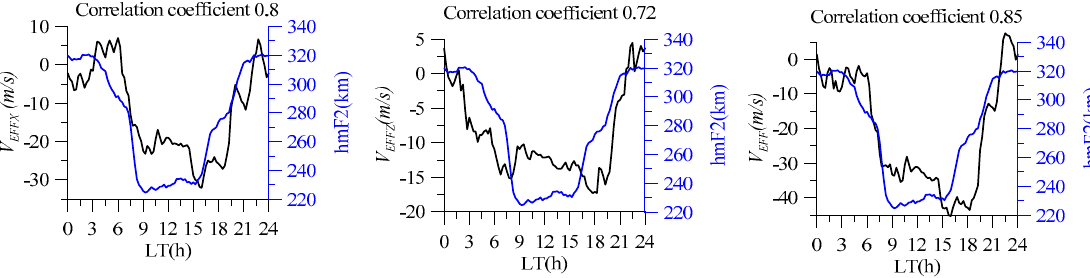
Figure 4. Comparison of meridional wind contribution ( left, black ), vertical wind contribution ( central, black ), and total contribution ( right, black ) to plasma drift velocity with peak height ( blue ) from the Irkutsk ionosonde.